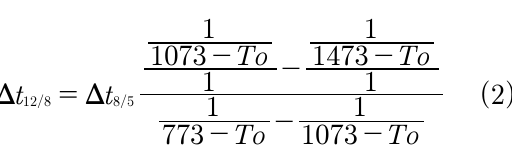
or slow cooling rates such as in a multipass welding.